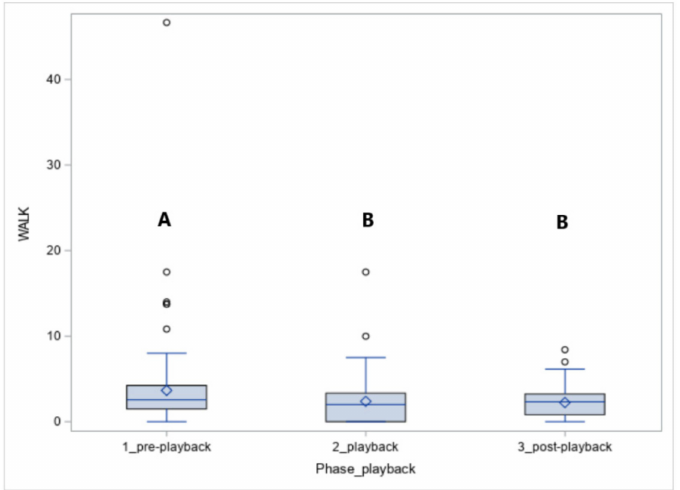
Figure 5. The number of steps in walk (WALK) in horses exposed to the vocalisation of predators. Values with A, B letters di ff er significantly at p < 0.01 between phases 1–3 (pre-, playback and